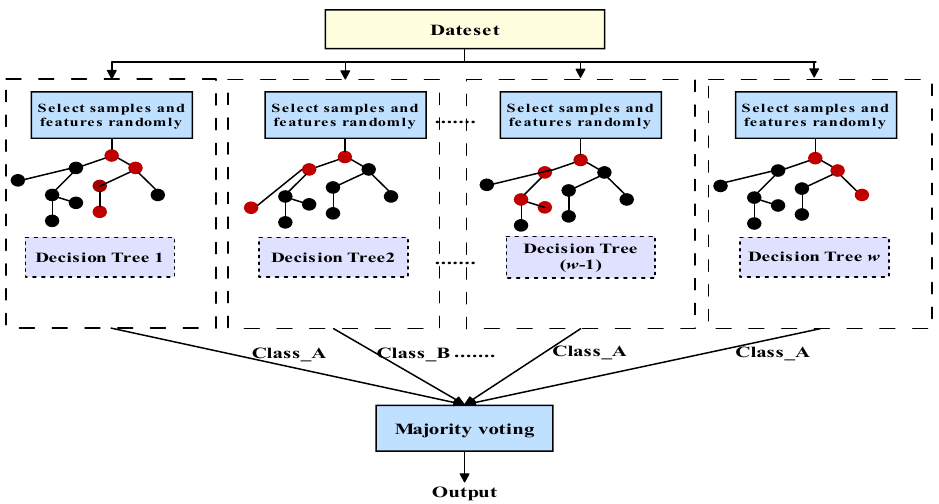
Figure 2. Basic structure of the random forest classifier.